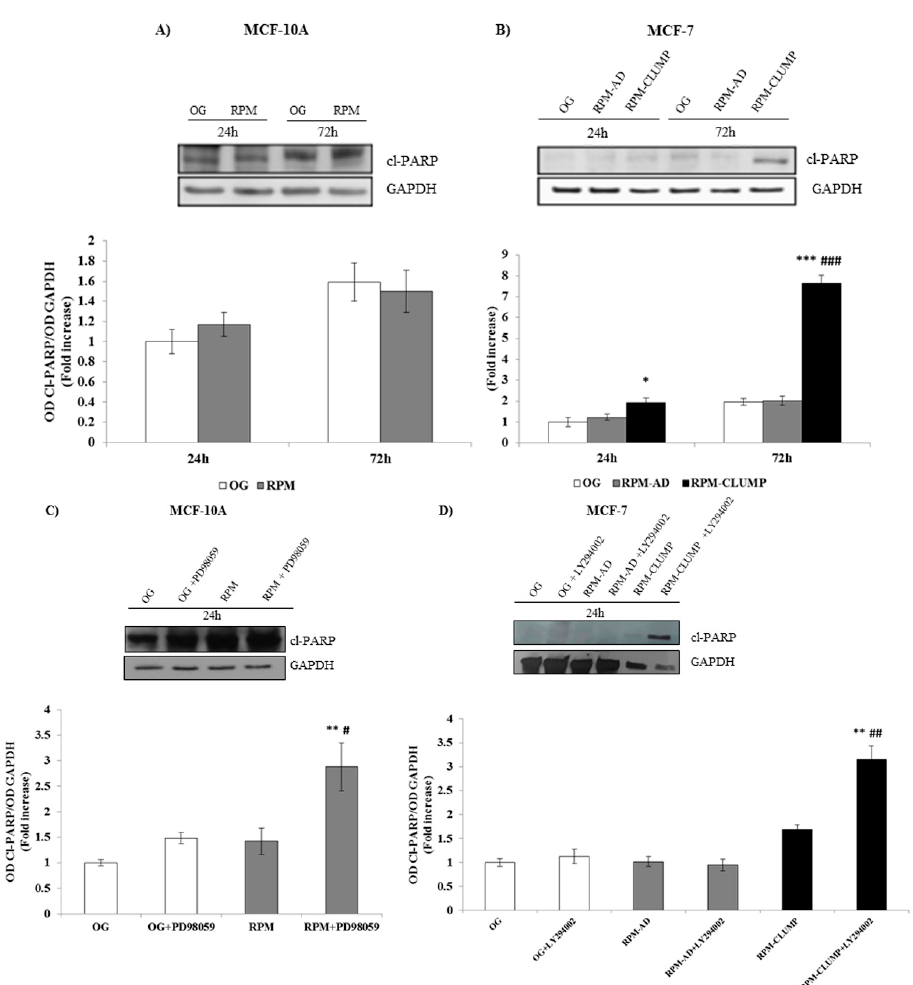
Figure 14. Immunoblot bar chart showing the expression of cleaved poly(ADP-ribose) polymerase (cl-PARP) in MCF-10A ( A ) and MCF-7 ( B ) in on-ground control cells, RPM adherent cells, and RPM cell clumps at 24 and 72 h. Columns and bars represent densitometric quantification of the optical density (OD) of a specific protein signal normalized with the OD values of the GAPDH serving as the loading control. Each column represents the mean value ± SD of three independent experiments. * p < 0.05; *** p < 0.001 vs. OG; ### p < 0.001 vs. RPM-AD by ANOVA followed by Bonferroni post-test. Immunoblot bar chart showing the expression of cl-PARP in MCF-10A ( C ) and MCF-7 ( D ) in on-ground control cells, RPM adherent cells, and RPM cell clumps at 24 h w/o the p-ERK inhibitor, PD89059, and w/o the p-AKT inhibitor, LY294002, respectively. Columns and bars represent densitometric quantification of the optical density (OD) of a specific protein signal normalized with the OD values of the GAPDH serving as the loading control. Each column represents the mean value ± SD of three independent experiments. In MCF-10A, ** p < 0.01 vs. OG; # p < 0.05 vs. RPM by ANOVA followed by Bonferroni post-test. In MCF-7, ** p < 0.01 vs. OG; ## p < 0.01 vs. RPM-CLUMP by ANOVA followed by Bonferroni